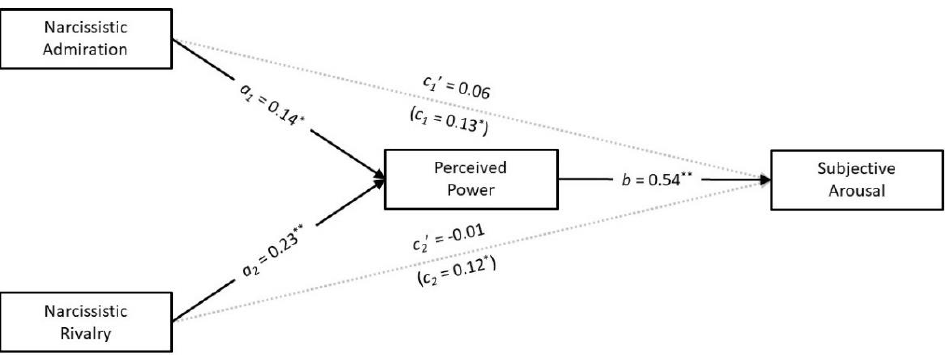
Figure 1. The results of the multilevel mediation analysis with perceived power mediating the associations that narcissistic admiration and narcissistic rivalry had with subjective arousal. Note. The solid black arrows represent significant associations, and the dotted grey lines represent nonsignificant associations. * p < 0.01; ** p < 0.001.